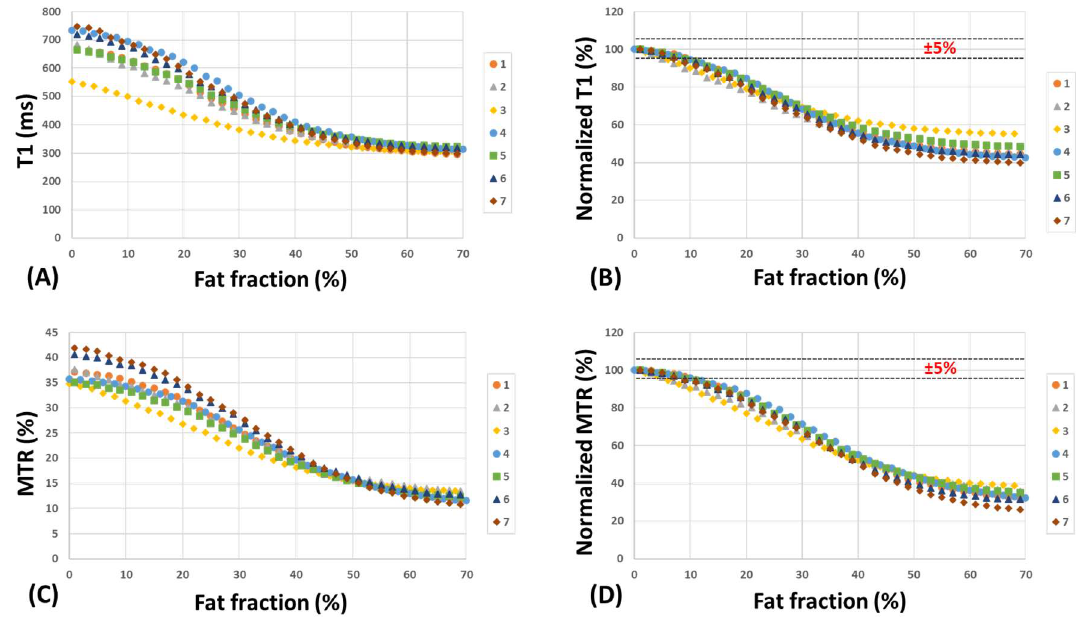
Figure 4. ( A ) T1 (ms) and ( B ) normalized T1 (%) versus FF within seven series of ROIs initiated with pure muscle ROIs (FF ≈ 0%) on the fat border and expanded by adding only neighboring pure lard voxels (FF up to 70%). ( C ) MTR (%) and ( D ) normalized MTR (%) versus FF within the same ROIs. T1 and MTR decreased by more than 5% for FF above 10%.